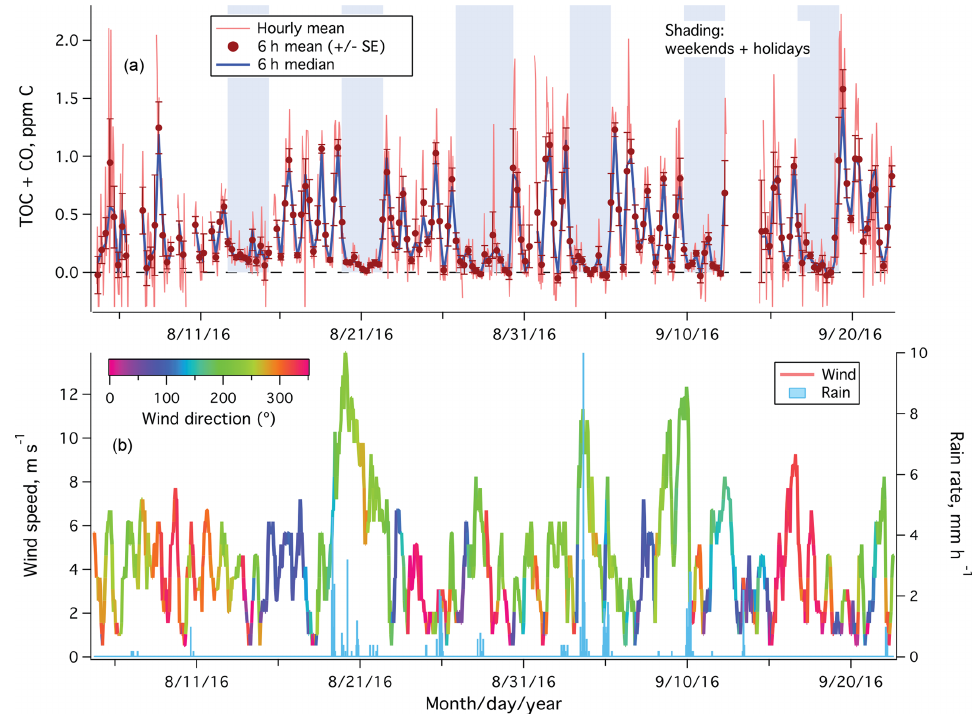
Figure 3. (a) Time series of TOC + CO in units of parts per million of carbon from the rooftop of Plymouth Marine Laboratory. Error bars on 6h means indicate standard errors; (b) wind speed (color-coded by wind direction) and rain